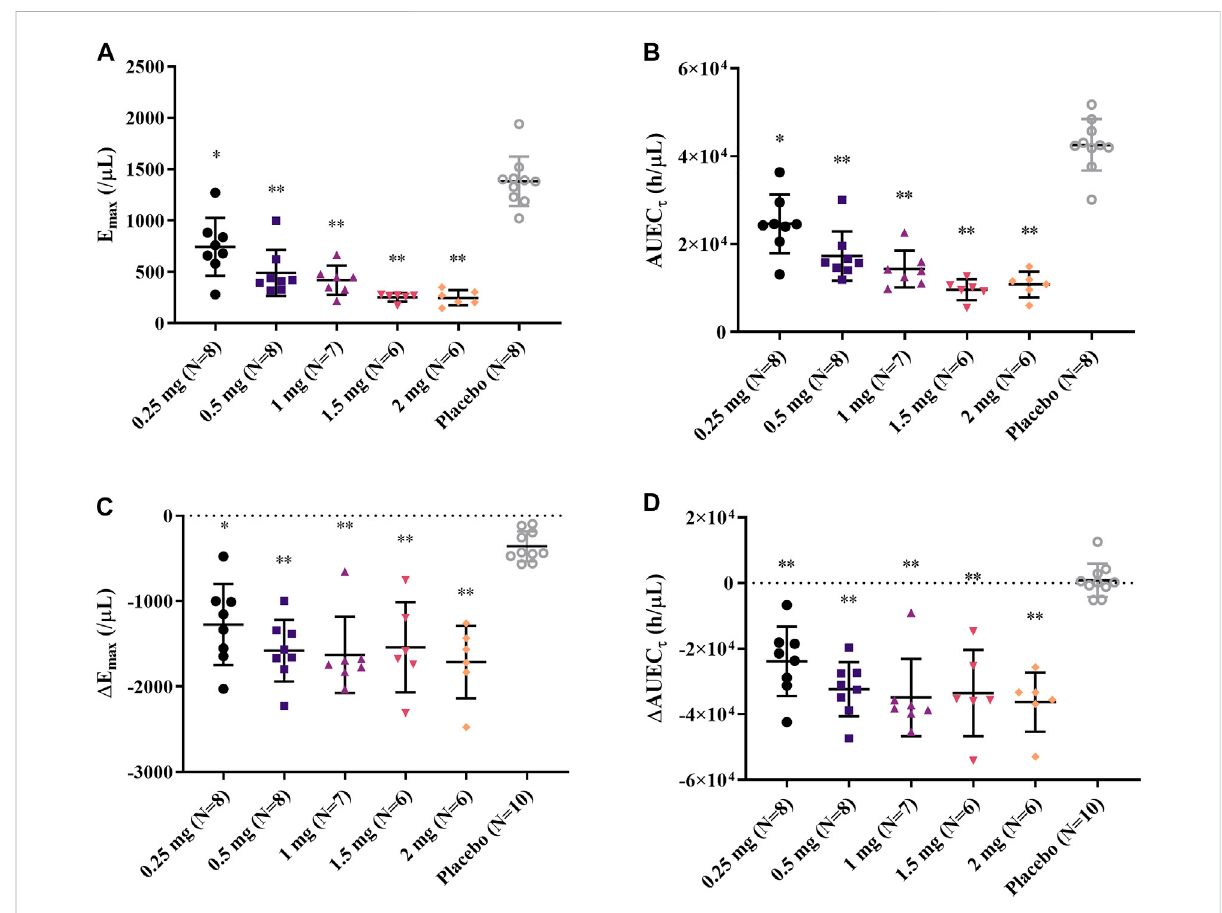
FIGURE 2 Individual (A) E max , (B) AUEC τ , (C) Δ E max , and (D) Δ AUEC τ after daily oral administration of 0.25, 0.5, 1, 1.5, and 2 mg LC51-0255 for 21 days. Notes: Middle line: mean value; upper and lower lines: standard deviations; p p < 0.05, versus placebo and pp p < 0.0001, versus